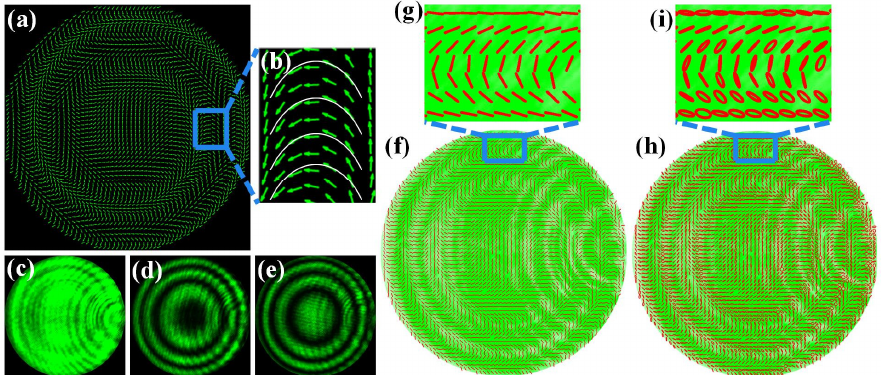
Figure 5. Generated vector beam with the desired phase profile δ 1 of Equation (10). ( a , b ) The overall and local theoretical SOPs of the vector beam, respectively; ( c – e ) The intensity patterns of the vector beam after inserting no polarizer, horizontal polarizer and vertical polarizer, respectively; ( f , g ) The overall and local experimental SOPs with the linear components of the Stokes parameters of the vector beam, respectively; ( h , i ) The overall and local experimental SOPs with the full linear components of the Stokes parameters of the vector beam, respectively.